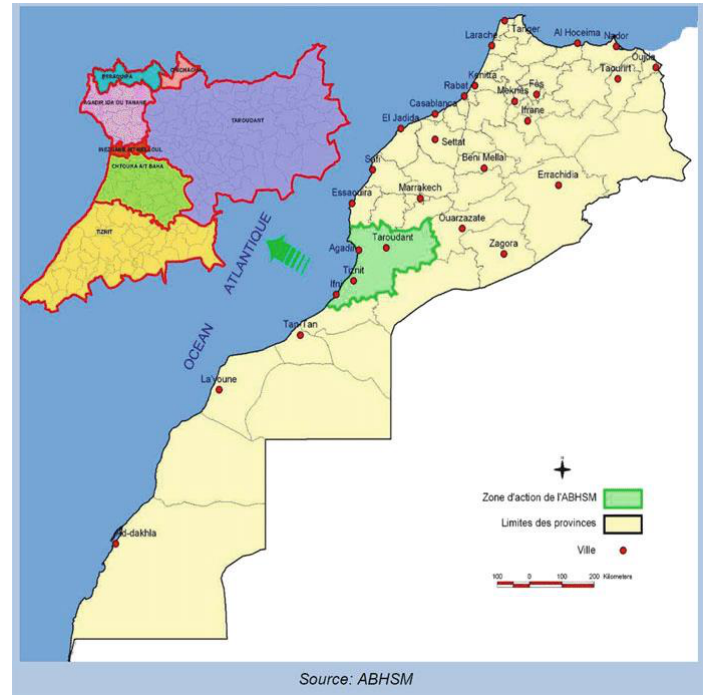
Figure 4. The Souss-Massa river basin [36]